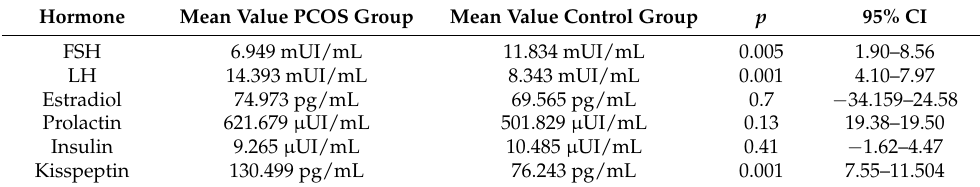
Figure 4. Univariate analysis between LH serum levels and PCOS ( p < 0.001). Circles represent high potential outliers and the stars represent high extreme values. Table 1. Univariate analysis between presence of PCOS and reproductive hormones levels during follicular phase of the menstrual